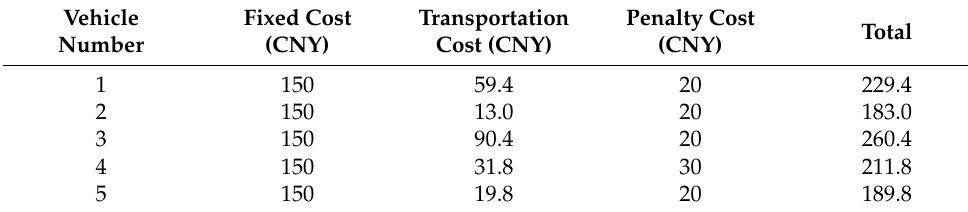
Table 16. Optimized delivery vehicle cost table.